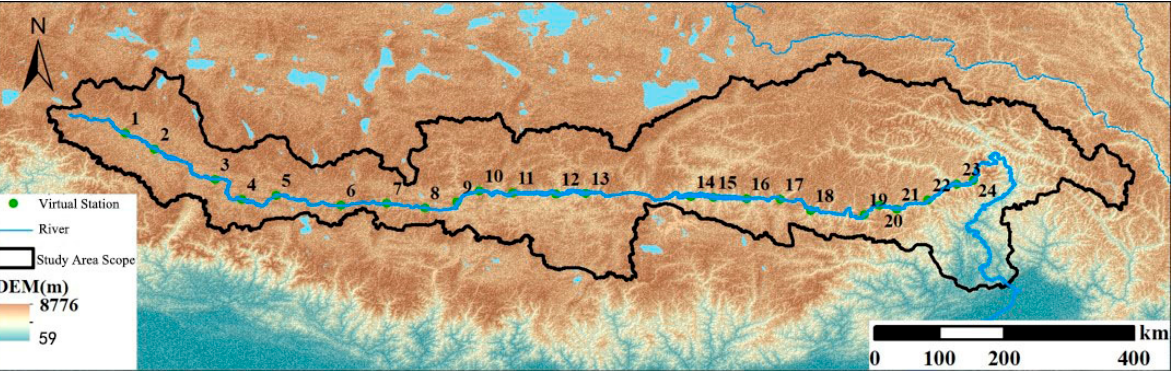
Figure 8. Location diagram of 24 Hydroweb data virtual stations along the main stream of the Yarlung Zangpo River. Table 3. Location of 14 Hydroweb data virtual stations within 3 km of ICESat-2 orbit. FID Latitude ( ◦